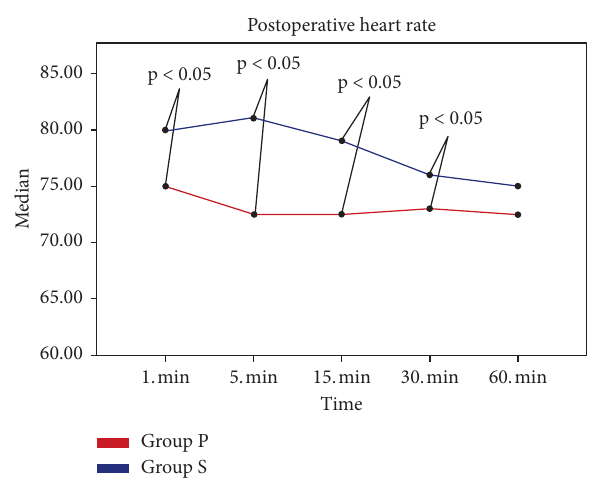
Figure 2: Between-group comparison of the HR postoperatively. HR: heart